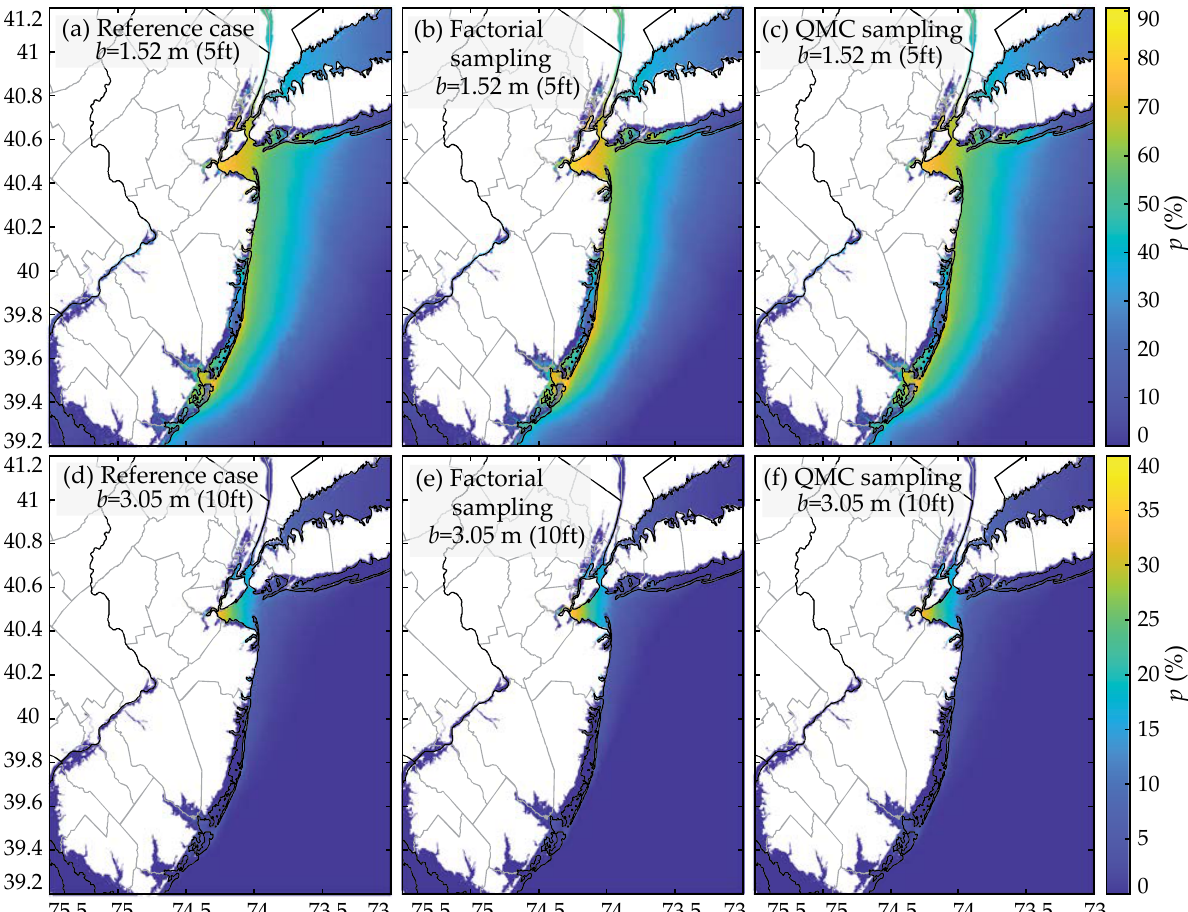
Figure 10. Distribution over the spatial domain of interest of the probabilities of exceeding thresholds 1.52 m (5 ft) (top row) and 3.05 m (10 ft) (bottom row) for advisory A 1 and scenario U 1 for super storm Sandy. Three different sampling approaches are presented for estimating the desired statistics: The reference case (left column) is presented to establish the comparisons between the factorial P-Surge sampling (middle column), and the QMC sampling (right column) for a N r value similar to the one used for the factorial P-surge